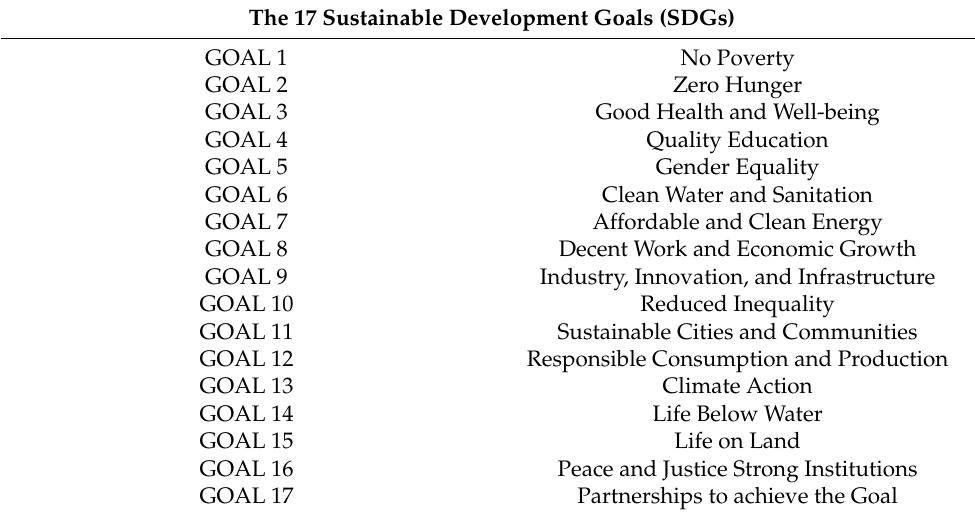
Table 2. The 17 sustainable development goals (SDGs) to transform our world, derived from [37]. The 17 Sustainable Development Goals (SDGs) (cid:1)